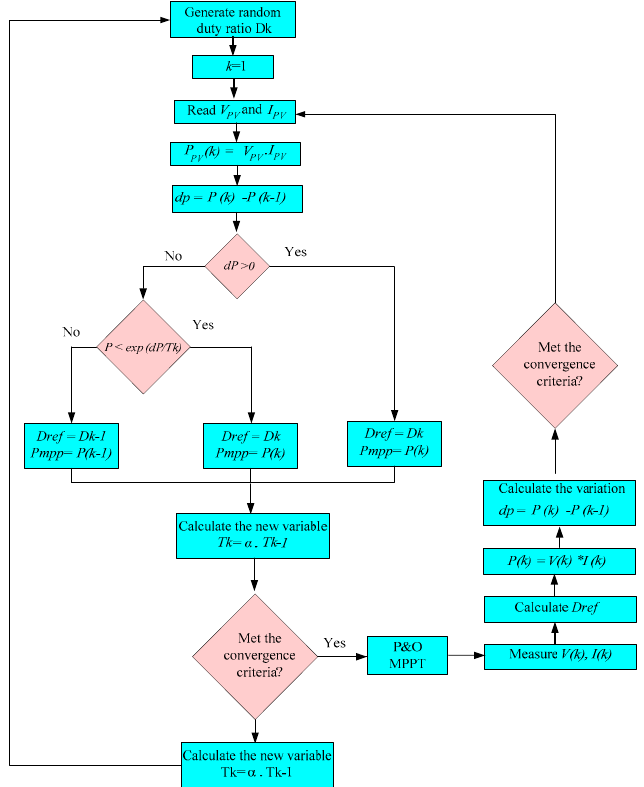
Figure 13. Flowchart of the SA-P&O technique.